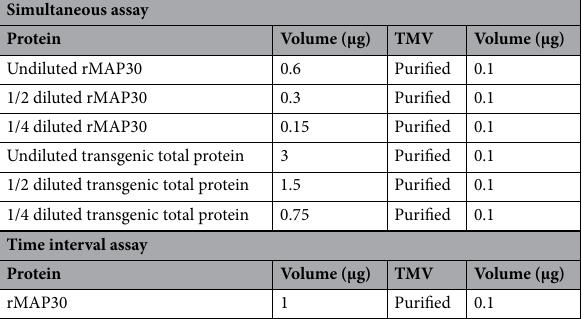
Table 3. Anti-TMV activity of MAP30. The different concentrations of purified recombinant MAP30 and the total protein extracted from transgenic lines are shown. Simultaneous assay indicates the treatments using MAP30 and TMV at the same time. Time interval assay indicates the treatments using MAP30 and TMV separately and in a period of the time.